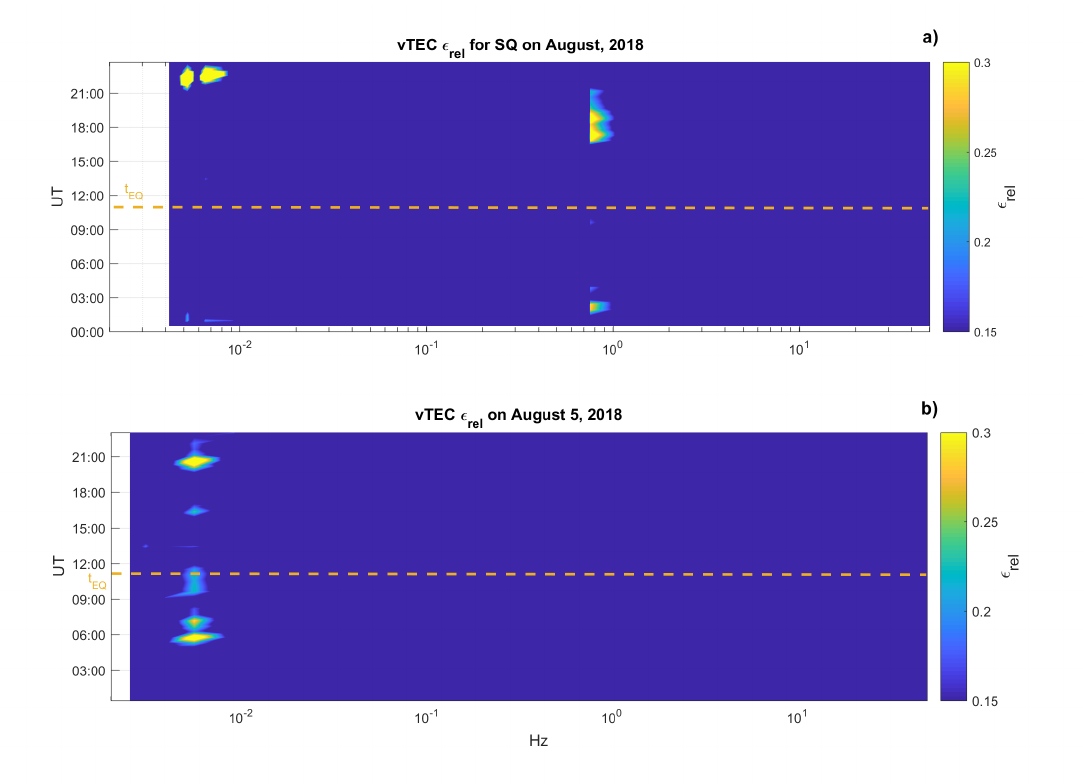
Figure 3. vTEC relative energy spectrogram evaluated over the earthquake epicenter. Panel ( a ) vTEC relative energy background for solar quiet conditions for August 2018; panel ( b ) vTEC relative energy evaluated on 5 August 2018. Colors are representative of the (cid:101) rel values. The yellow dashed line represents the time of the earthquake